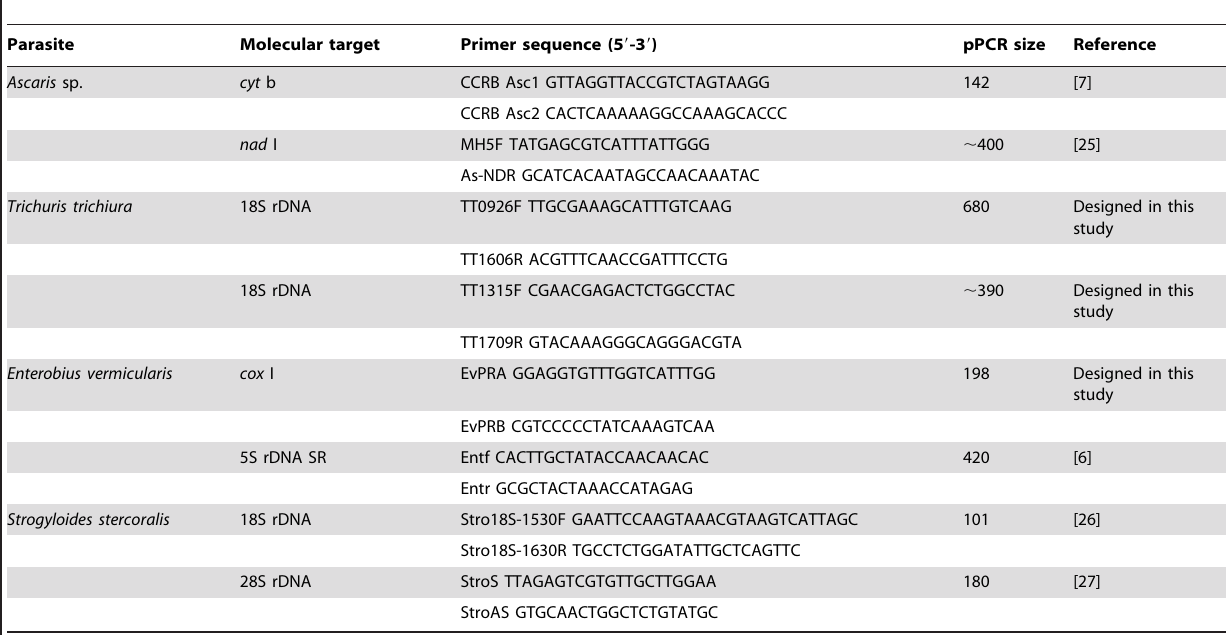
Table 1. Molecular targets used in the Molecular Paleoparasitological Hybridization